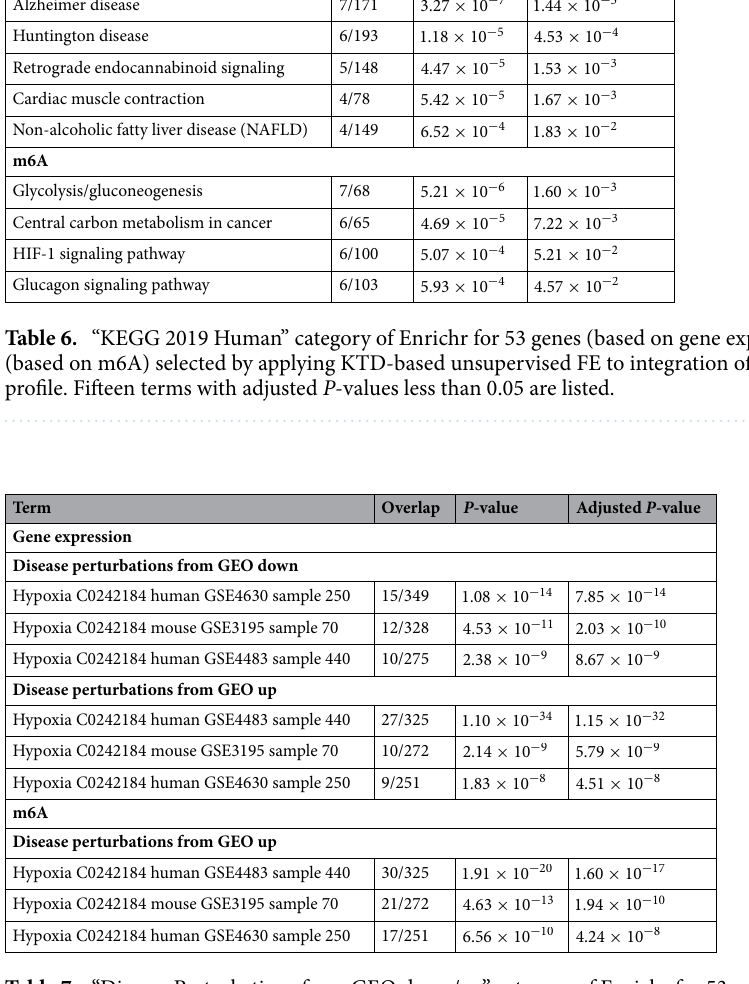
Table 7. “Disease Perturbations from GEO down/up” category of Enrichr for 53 genes (based on gene expression) and 200 genes (based on m6A) selected by applying KTD-based unsupervised FE to integration of gene expression and m6A profiles. Nine hypoxia experiments with adjusted P -values less than 0.05 are listed.